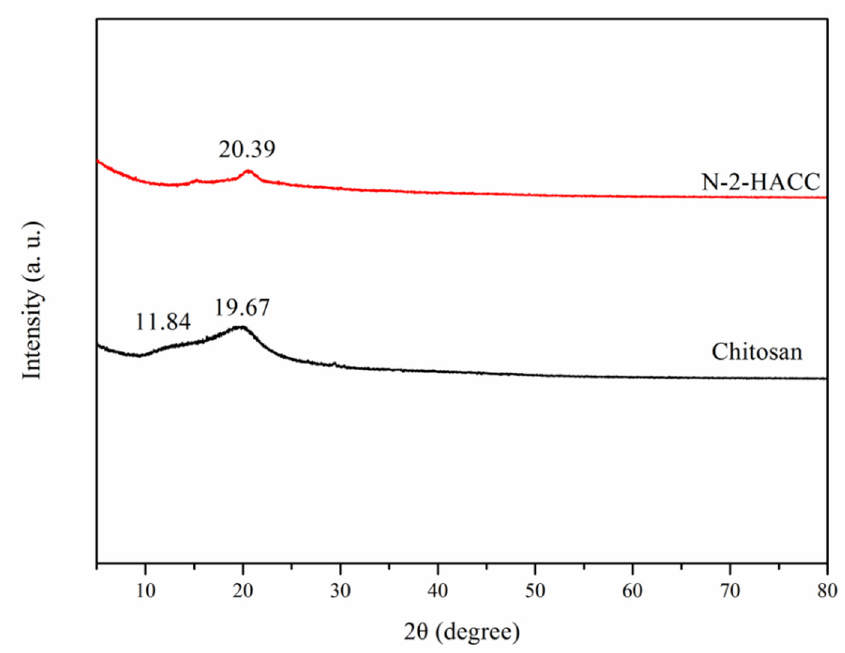
Figure 4. XRD of CS and N-2-HACC.